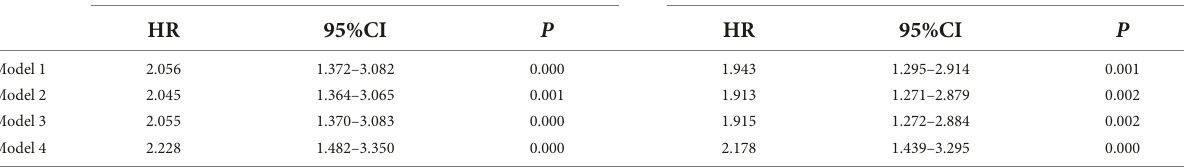
TABLE 2 The association of (cid:49) PNI, (cid:49) GNRI with major adverse cardiovascular event (MCE) risk. Association between the (cid:49) PNI and MCE risk Association between the (cid:49) GNRI and MCE risk HR 95%CI P HR 95%CI